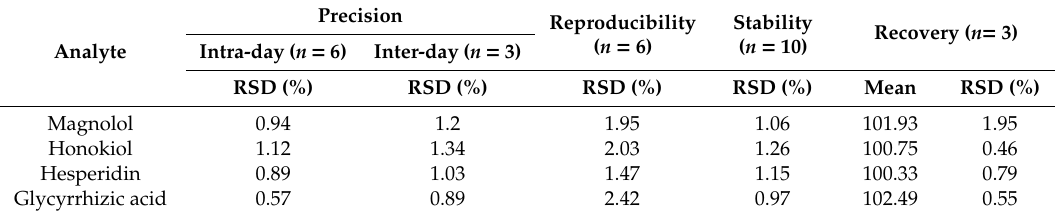
Table 2. Precision, repeatability, stability, and recovery results of four potential active ingredient markers. RSD = relative standard deviation.